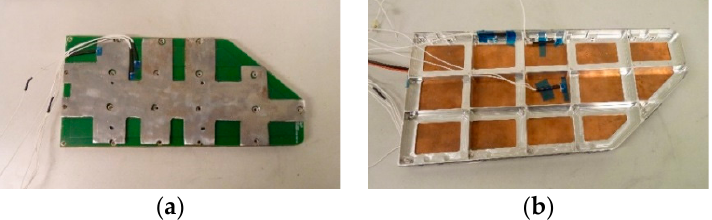
Figure 22. New PCB design for improved heat transfer from the PCB to the stiffener ( a ) top view ( b ) bottom view.